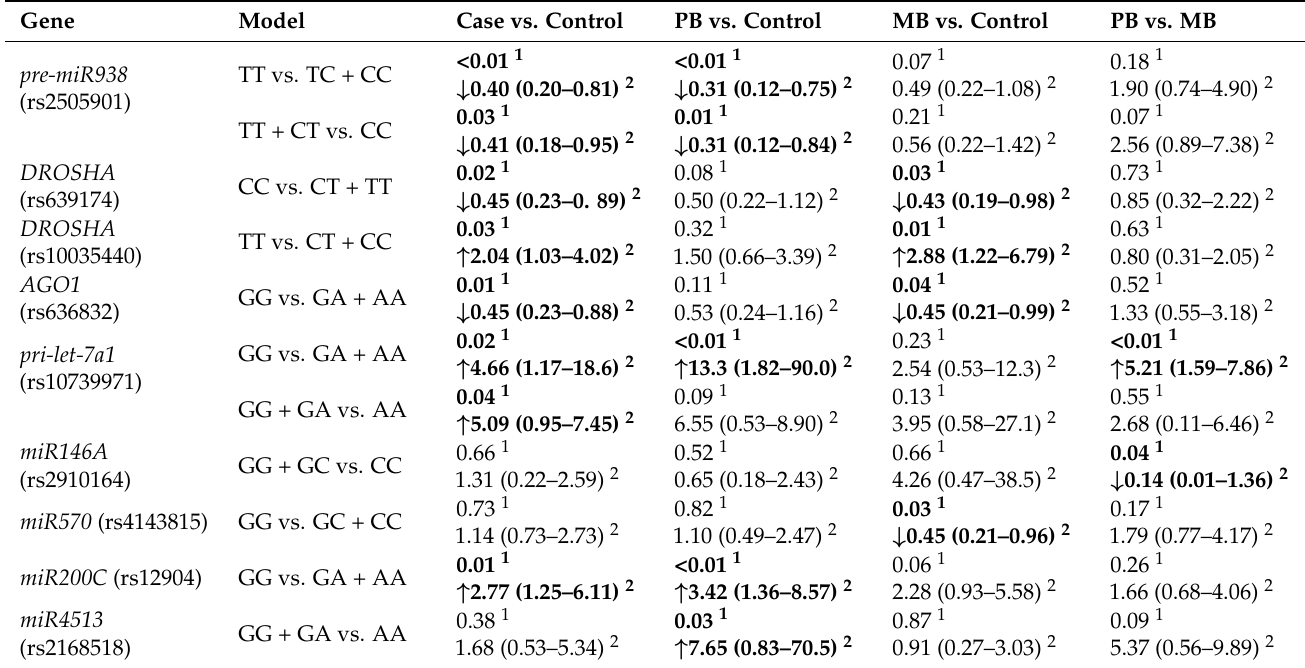
Table 2. Overview and comparison of the main results found according to the genotype associations between all the different groups studied. The values in bold show comparisons with a significant